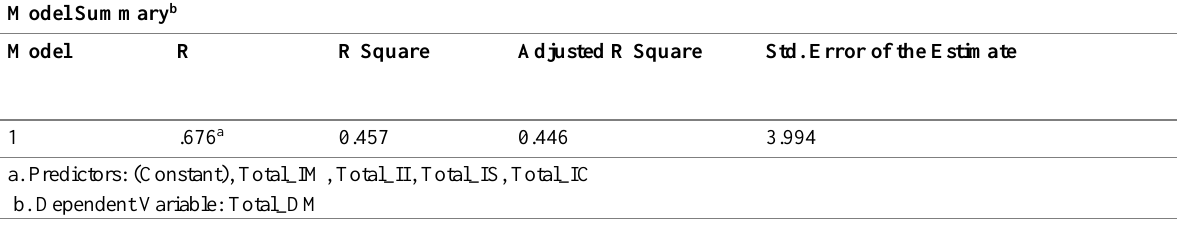
Table 13: Coefficient Determination and R Adjusted